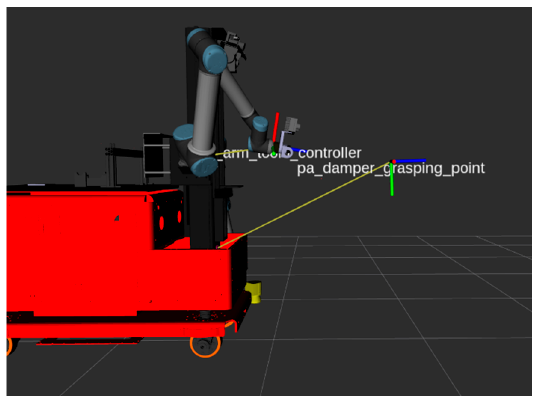
Figure 13. Rviz frame representation.